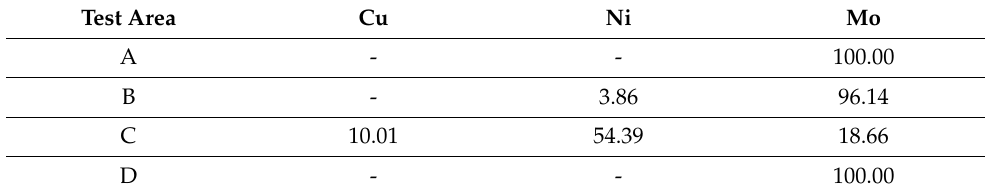
Figure 3. X-ray diffraction pattern of laser: ( a ) X-ray diffraction pattern of surface laser; ( b ) X-ray diffraction pattern of the cross-section laser. Table 1. Point energy spectrum analysis results for different areas of the cladding layer